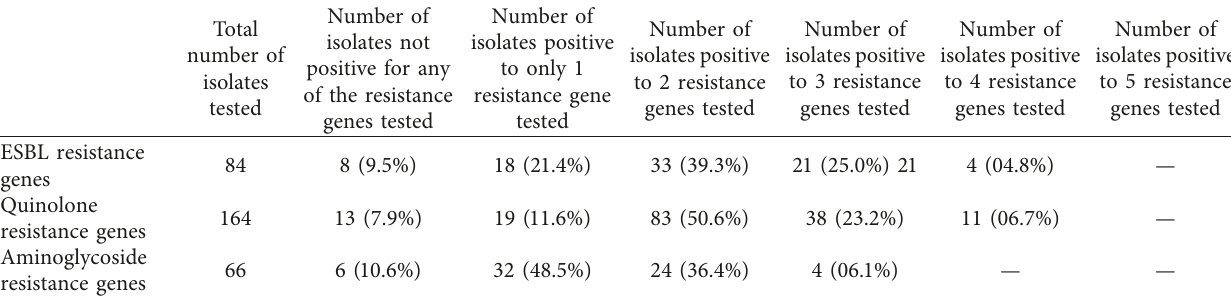
Figure 9: Gel image showing the amplification of the aph(3 Table 12: Co-occurrence of resistance genes in isolates.